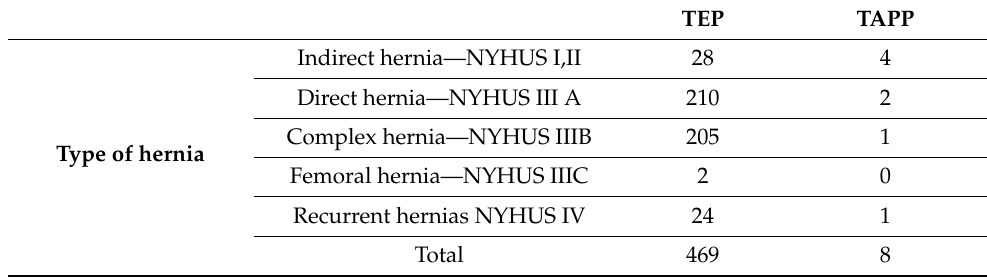
Table 5. The type of hernia and laparoscopy used as a surgical solution (1).